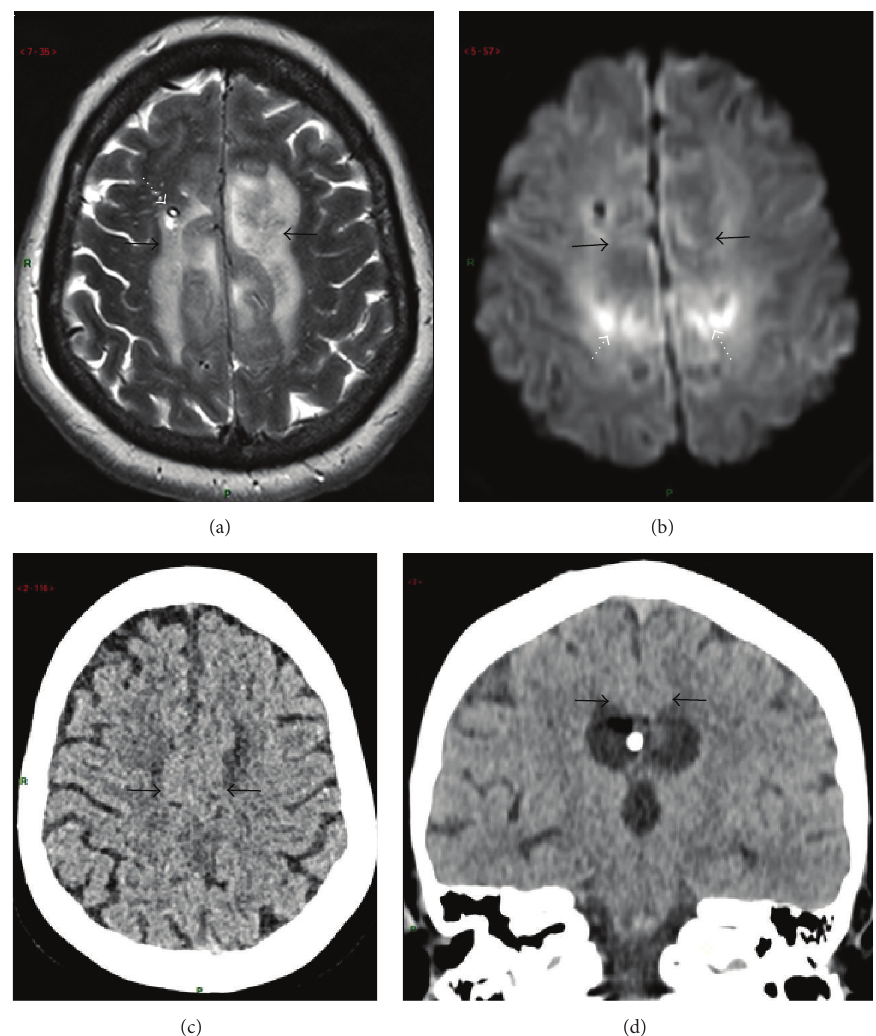
Figure 4: MRI work-up (a-b) at acute phase and delayed (4 months) CT scanner follow-up imaging (c-d) of patient 2. (a) T2-weighted fast-spin echo (FSE) axial transverse view through cingulate gyri demonstrating oedema-related strong hypersignal intensity within them on both sides. Ventricular draining catheter is seen on right frontal area (dotted white arrow). (b) Axial transverse diffusion-weighted ( 𝑏 factor = 1000 s/mm 2 ) view in similar slice location failed to reveal hypersignal intensity within the same cingular areas (black arrows), thereby excluding ischaemic cytotoxic oedema. Only false positive artifacts due to adjacent hematoma were seen (arrows). (c-d) CT scanner axial transverse (c) and coronal reformatted (d) images from helical acquisition demonstrating integrity of the cingulate gyri